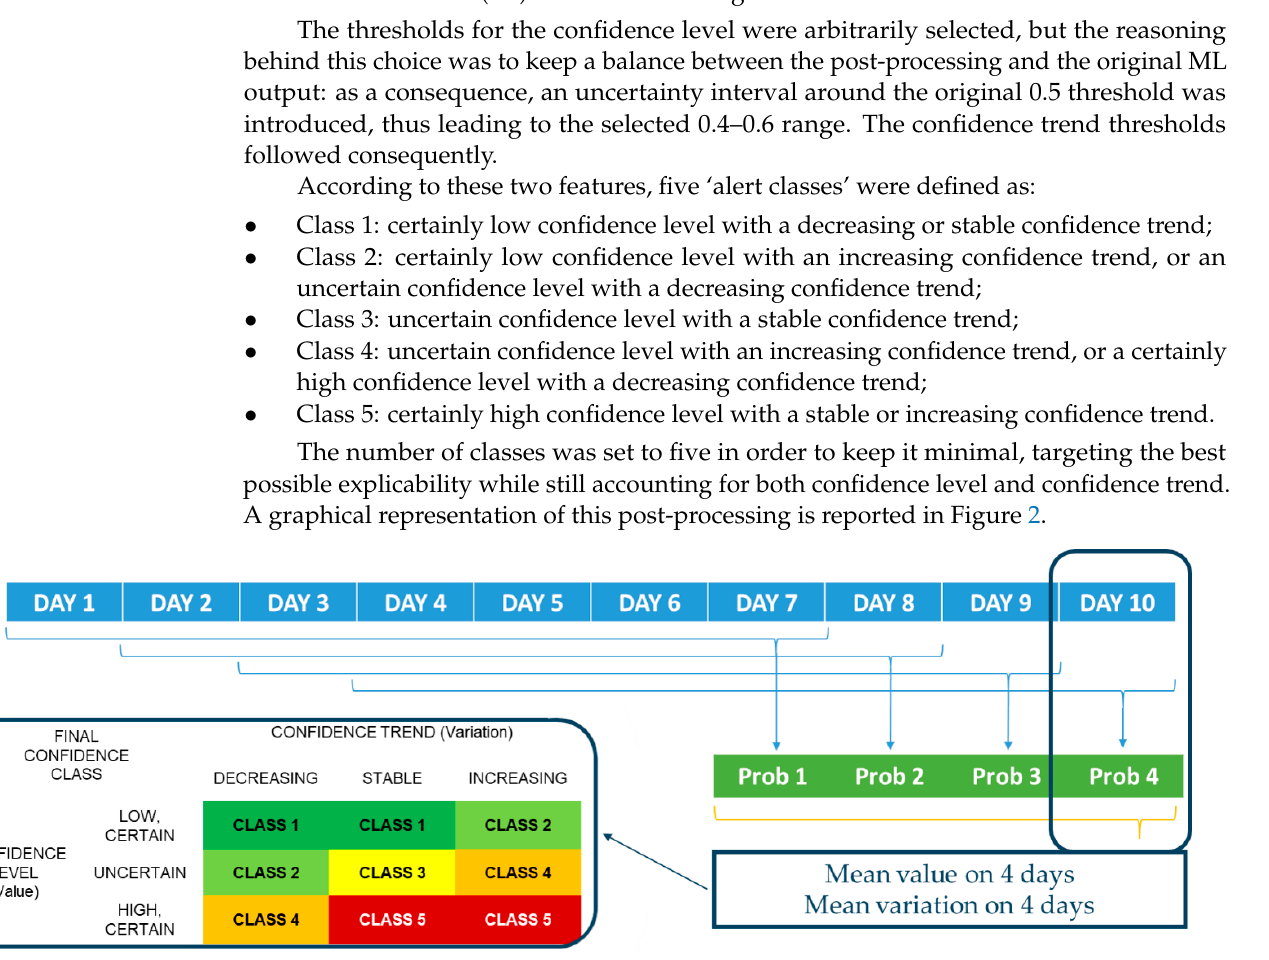
Figure 2. Post-processing elaboration of a machine learning model probability output, applied to classify the time series of ambulances dispatched and calls received by EMS for respiratory and infective issues (see text for details), to distinguish between a scenario of no epidemic diffusion and a scenario of active spreading by generating five possible classes of alert.